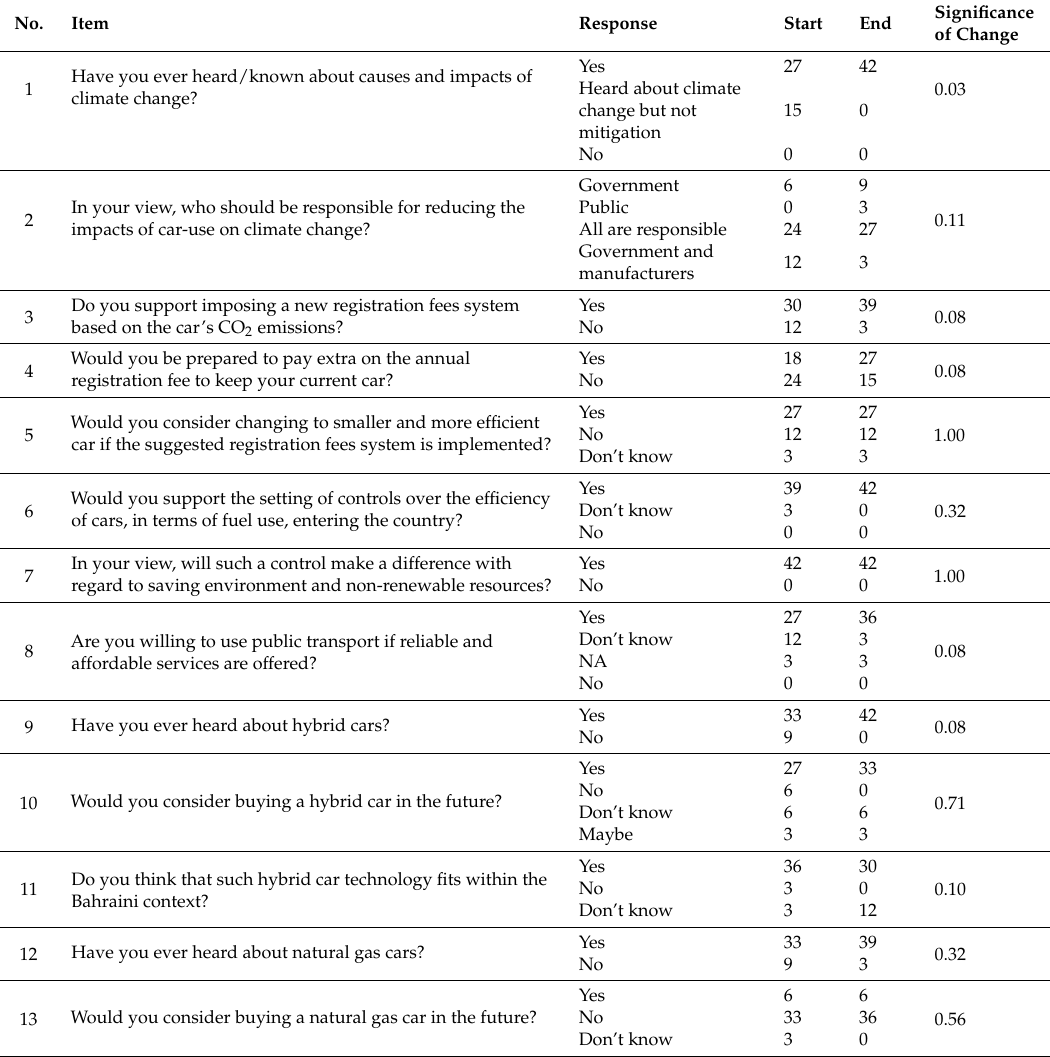
Table 3. A comparison of participants’ views obtained from questionnaires completed at the beginning and conclusion of